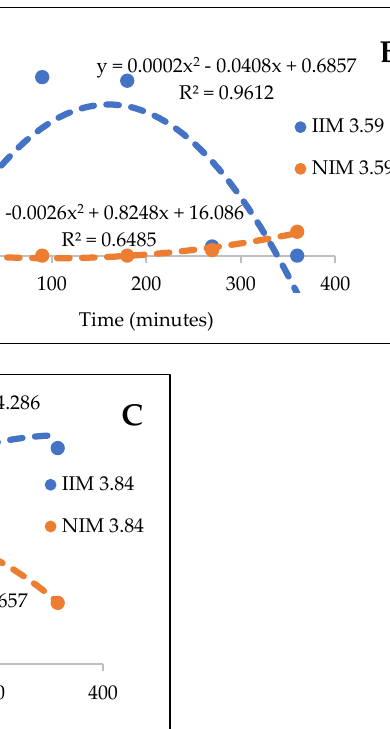
Figure 10. Adsorption result of NIM dan IIM with the polysulfone addition of ( A ) 3.34 g ( B ) 3.59 g ( C ) 3.84 g.